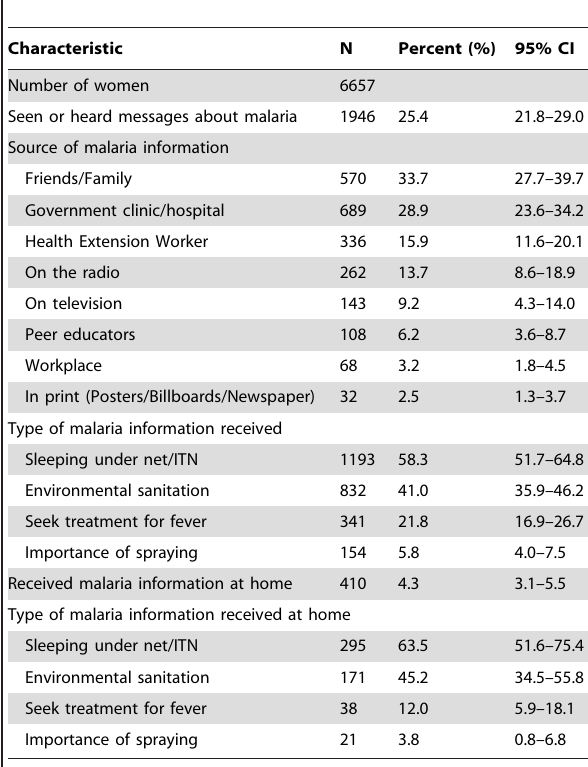
Table 2. Summary of malaria information received amongst women age 15–49 years, Ethiopia,